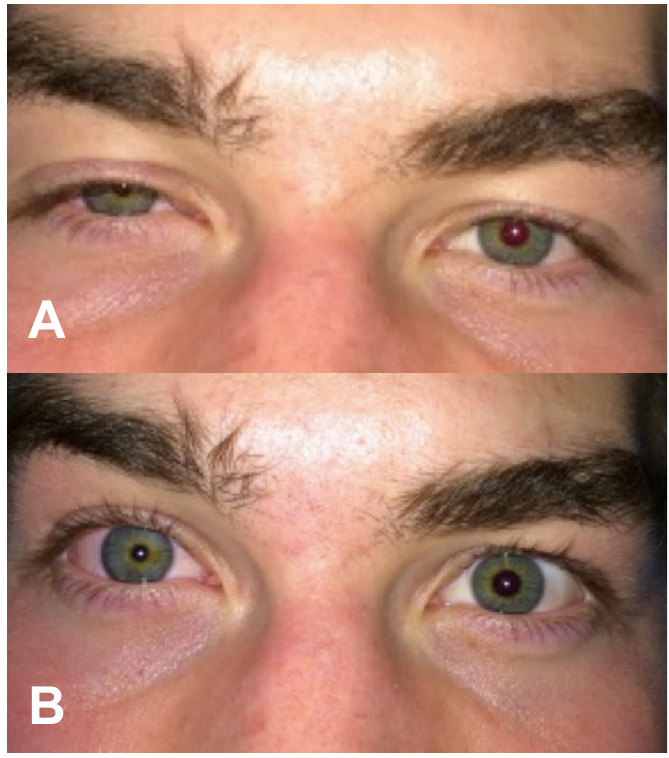
Figure 3. Horner’s syndrome after block placement with A , ptosis and B ,